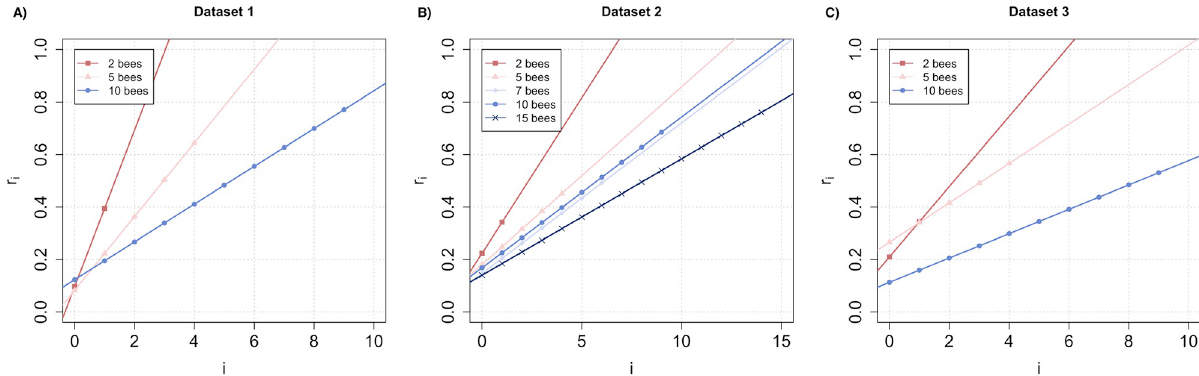
Fig 5. Likelihood to sting as a function of alarm pheromone units, based on optimisation of the parameter points with a linear model. The optimisation was run separately for each group size, for the 3 datasets available.